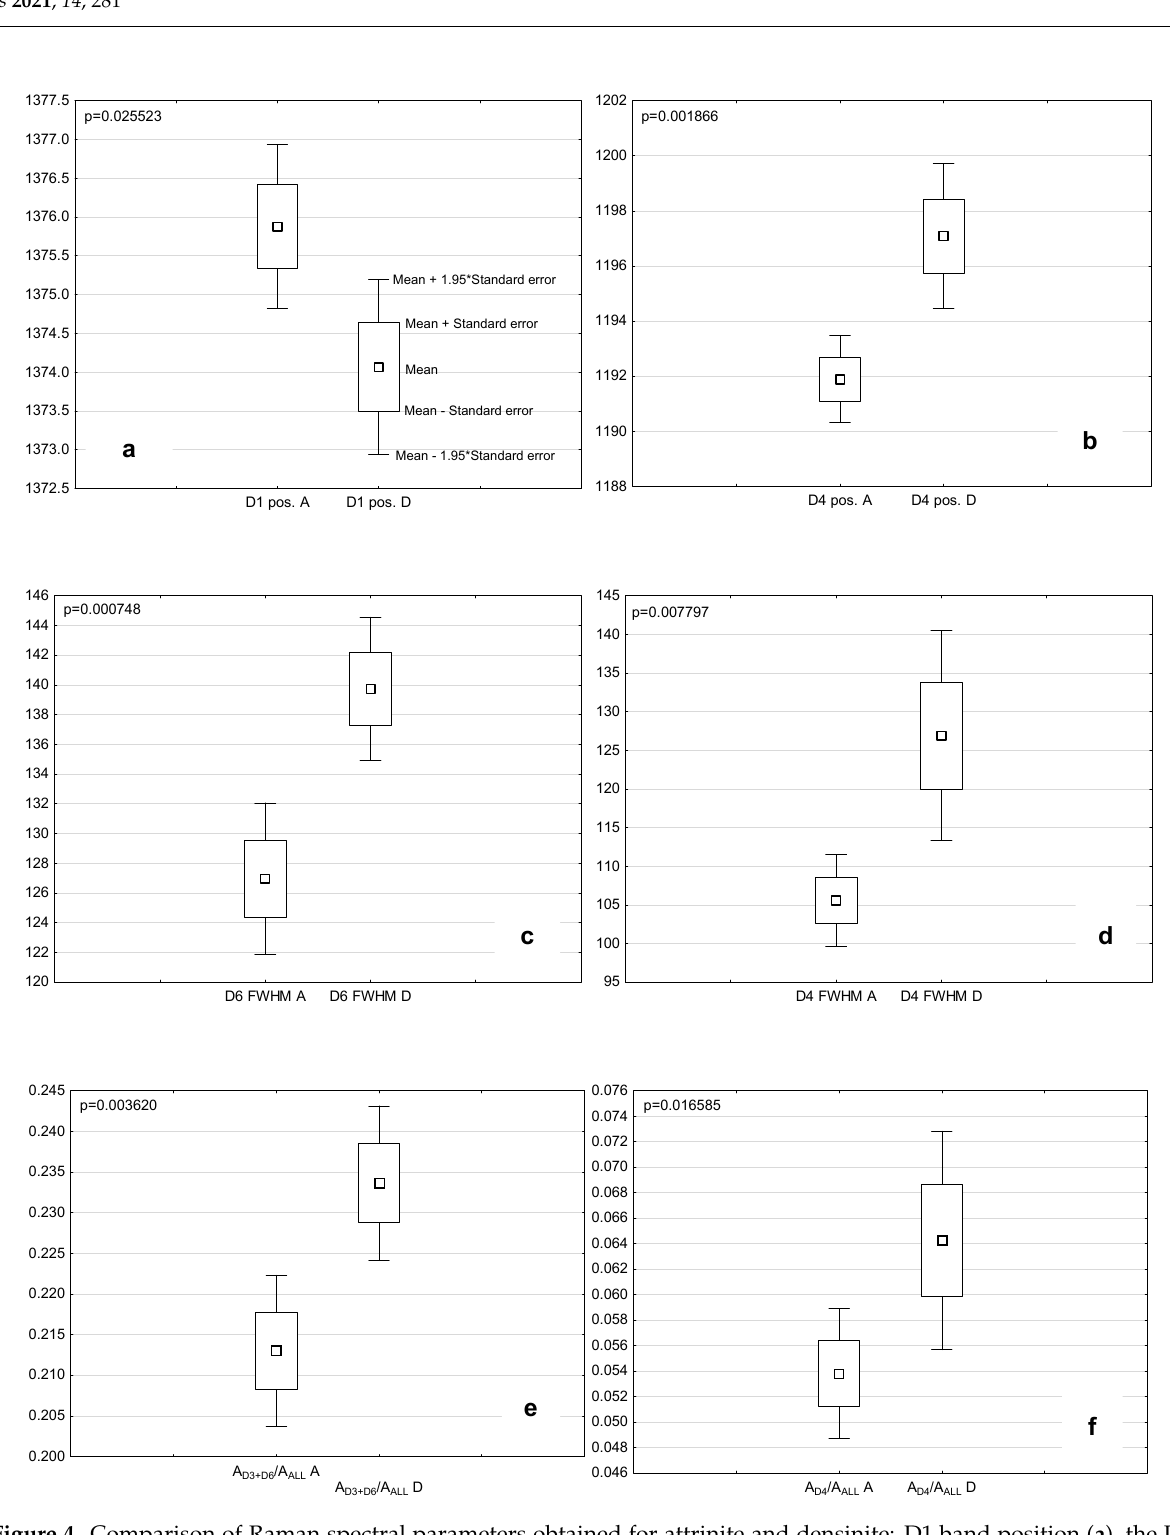
Figure 4. Comparison of Raman spectral parameters obtained for attrinite and densinite: D1 band position ( a ), the D4 band position ( b ), the D6 band FWHM ( c ), the D4 band FWHM ( d ) the A D3+D6 /A ALL ratio ( e ) and A D4 /A ALL ratio ( f ). Explanation: pos.—position; A—attrinite; D—densinite.